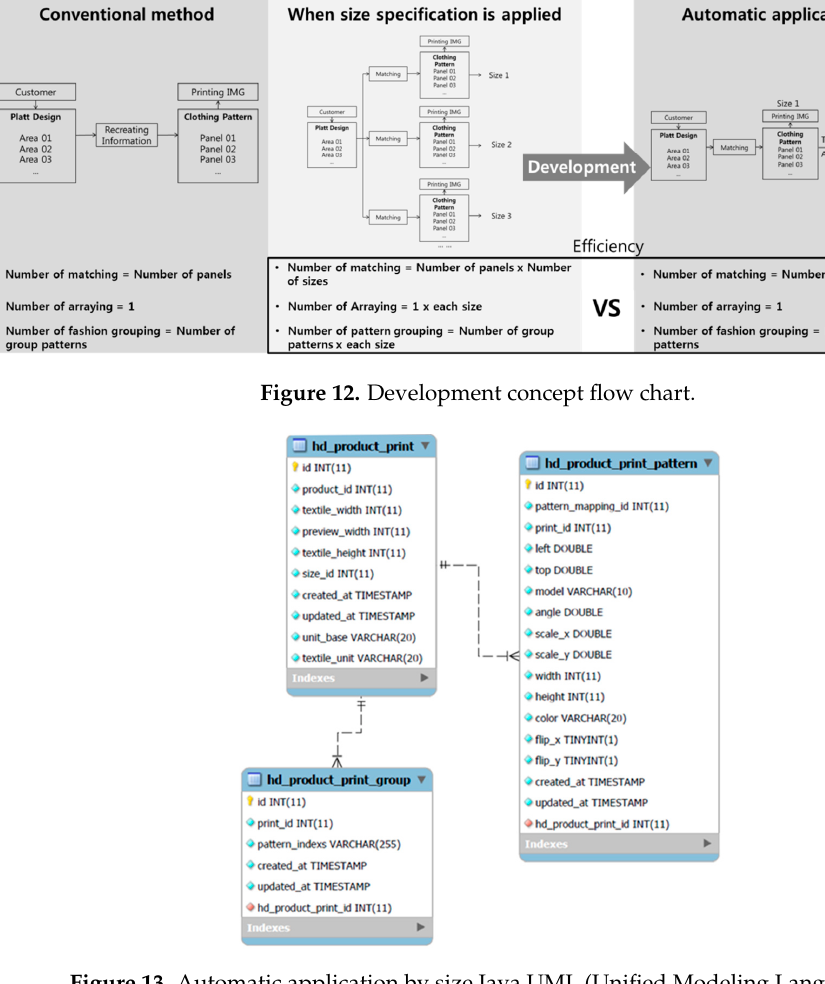
Figure 13. Automatic application by size Java UML (Unified Modeling Language).